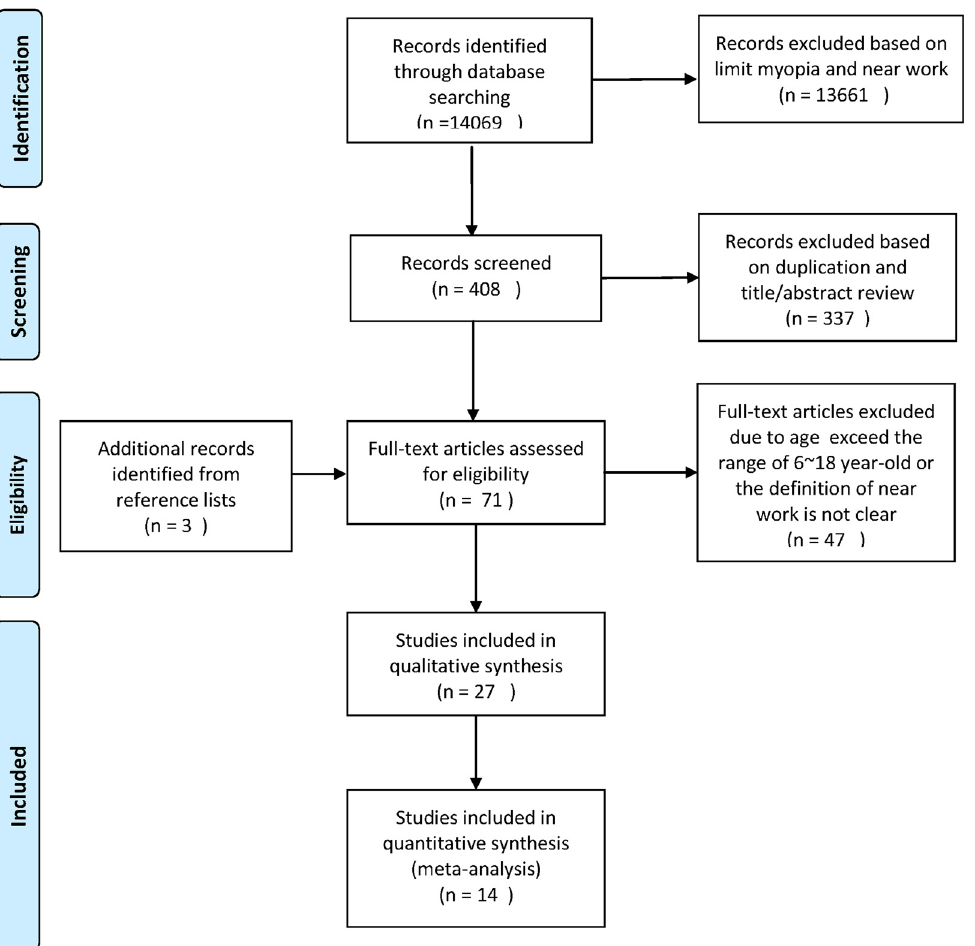
Fig 1. Flow diagram outlining the selection process for the inclusion of studies in the systematic review and meta-analysis. The electronic database searches identified 14,069 citations. After evaluating these citations and their bibliographies, 11 cross-sectional and 3 cohort studies met the inclusion criteria for quantitative analysis for this systemic review. From : Moher D, Liberati A, Tetzlaff J, Altman DG, The PRISAM Group (2009). P referred R eporting l tems for Systematic Reviews and M eta- A nalyses: The PRISAM Statement. PloS Med 6(6): e1000097. doi:10.1371/journal.pmed1000097. For more information, visit